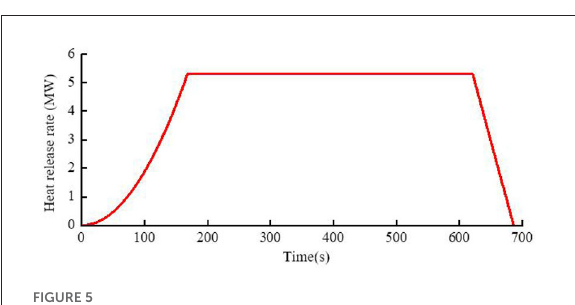
FIGURE5 Growth curve of heat release